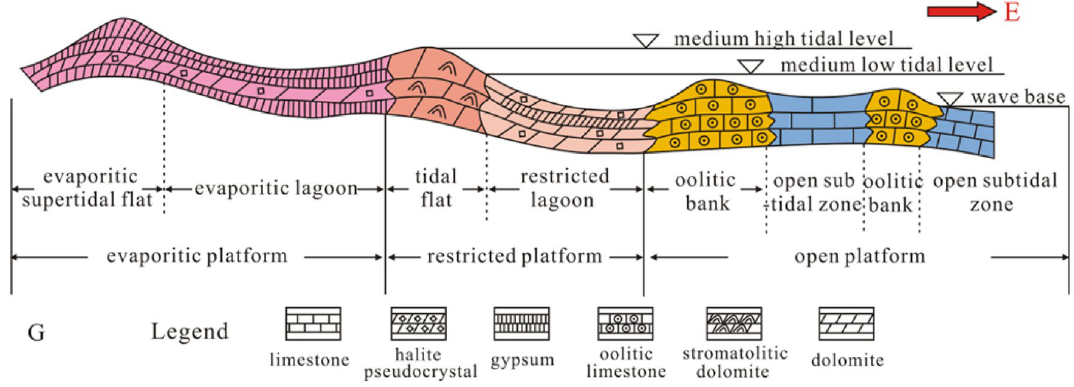
Fig. 7 Sedimentary model of carbonate platform in the Jialingjiang Formation, the Sichuan